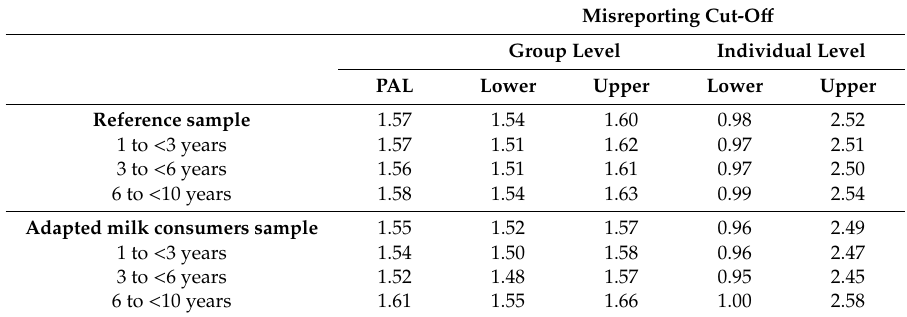
Table 1. Calculated energy cut-o ff for at group and individual levels for the Nutritional Study in Spanish Pediatric Population (EsNuPI) ( n =